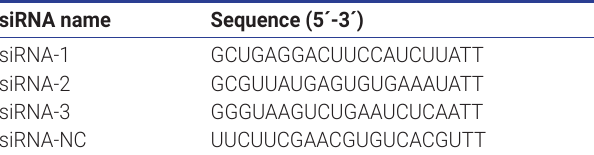
Table 2. siRNAs sequences used for RNA